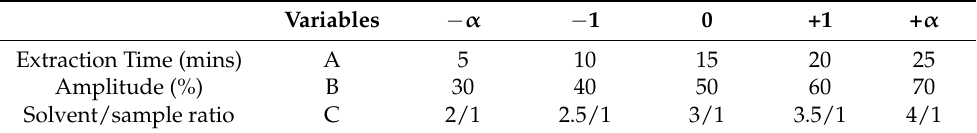
Table 1. Experimental ranges and levels of three variables tested in Central Composite Design.